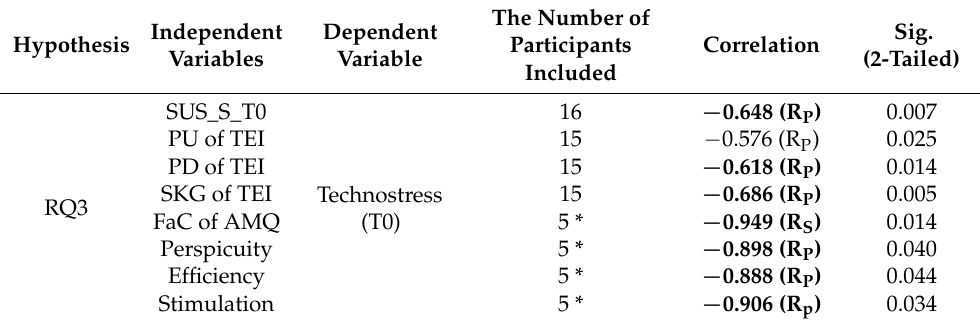
Table A8. Correlation scores. R p represents the Pearson Correlation Coefficient and R s represents the Spearman correlation coefficient.